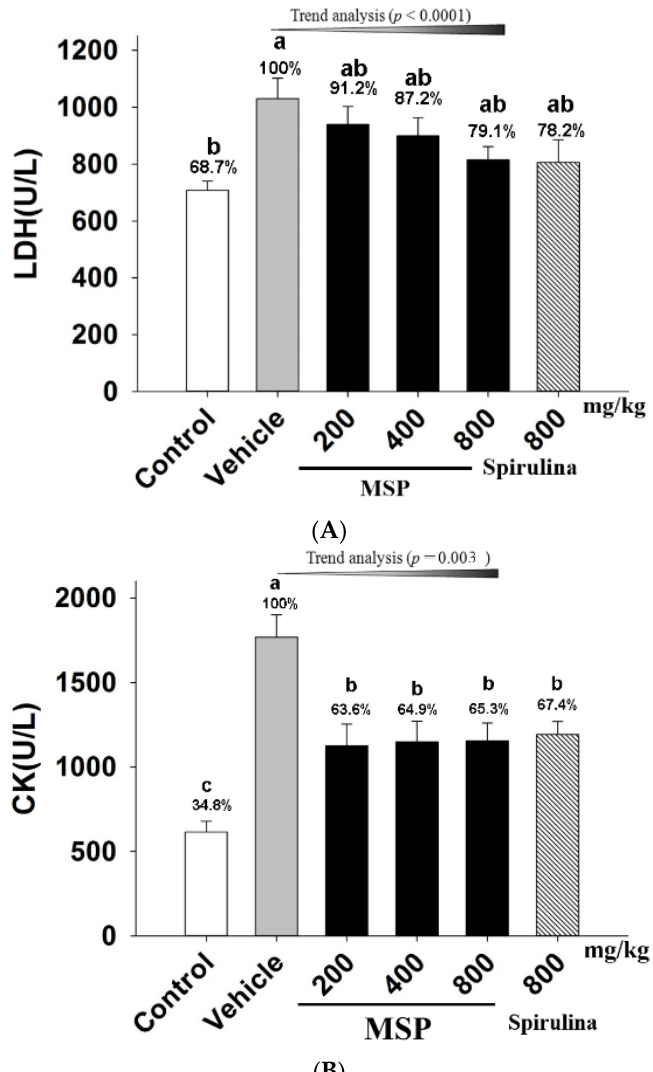
Figure 4. Effects of MSP on plasma lactic dehydrogenase (LDH) ( A ) and creatine phosphokinase (CK) ( B ) in mice after swimming for 30 min. Control group (open column), vehicle group (grey column), MSP-treated groups (200, 400, 800 mg/kg/day, black column), spirulina group (800 mg/kg/day, twill column). Data are mean ± standard error of the mean (SEM) with n = 8 mice per group. Bars with different letters (a, b) denote significant difference at p < 0.05. Percents shown above the bars represent percentage of the vehicle treatment.